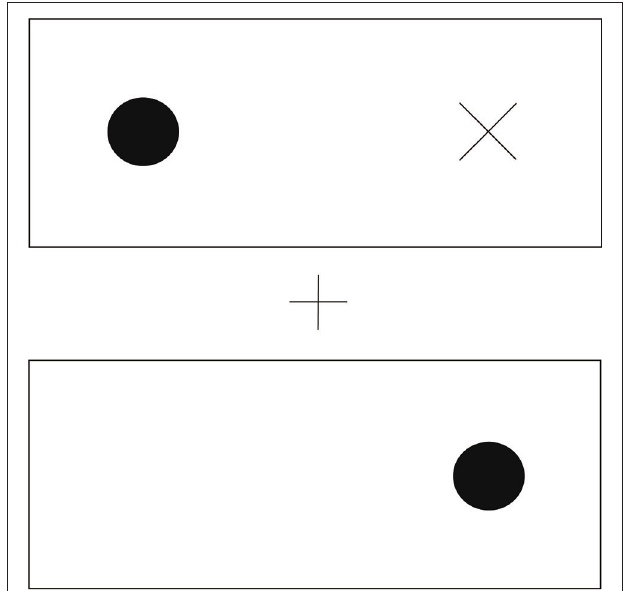
FIGURE 1 | The spatial layout of the stimuli. In the center we see a fixation cross, above and below are two rectangles. A cue appears at the x and disappears, followed by a target at one of the two circles. The subject’s task is to indicate the color of the target. Subjects respond faster to cues appearing within the same shape as the cue, even though they are as far from the cue as the target in the other shape.